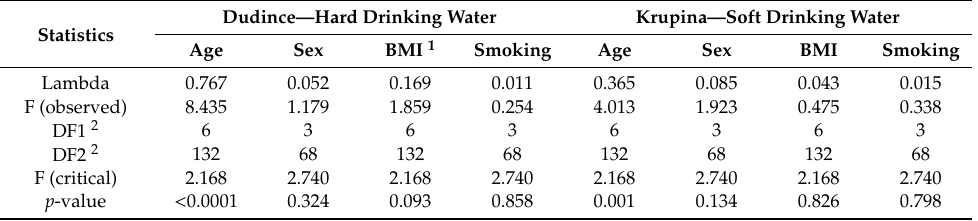
Figure 5. Differences between the arterial and actual age of residents living in areas with soft and hard drinking water. Horizontal continuous lines are the median values. Table 5. Results of multivariate variance analysis (MANOVA; Lawley–Hotelling trace